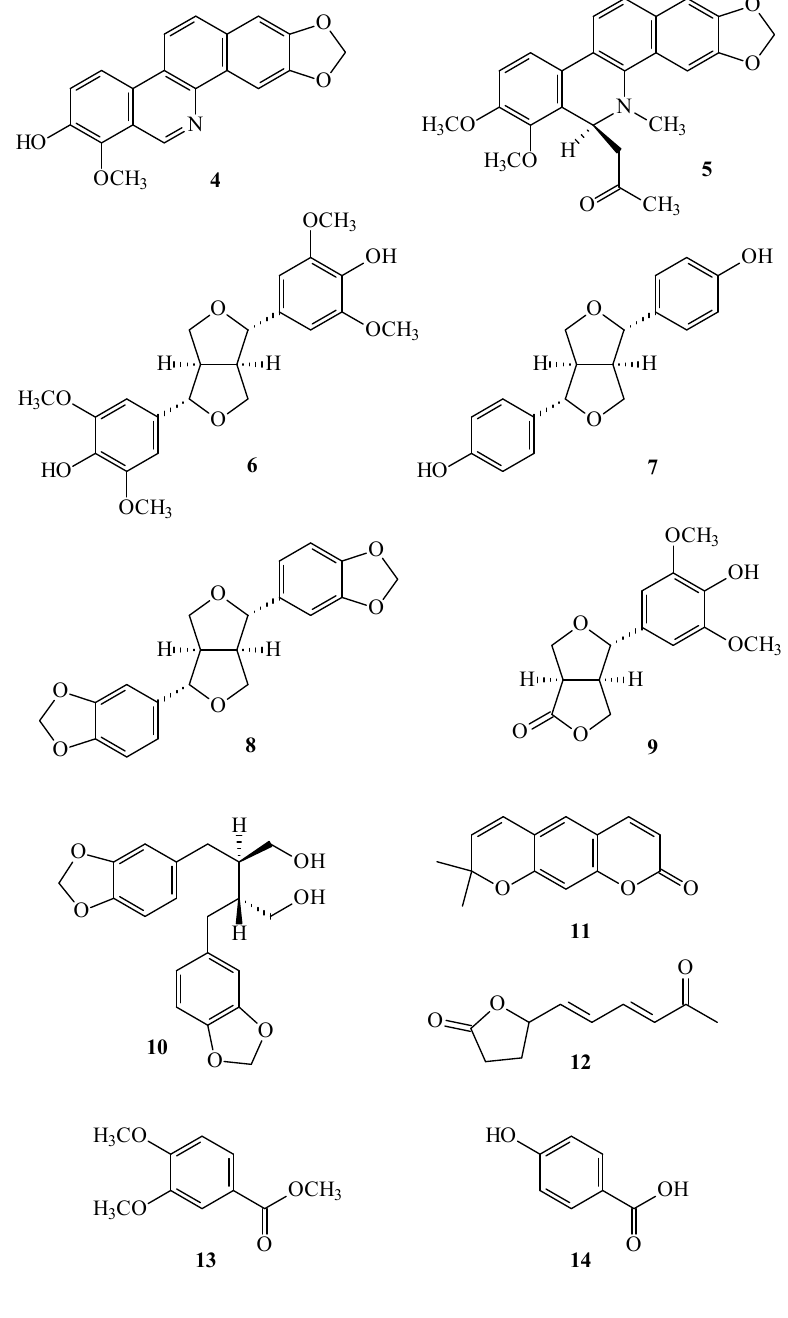
Figure 2. The chemical structures of known compounds 4 – 14 isolated from Zanthoxylum ailanthoides